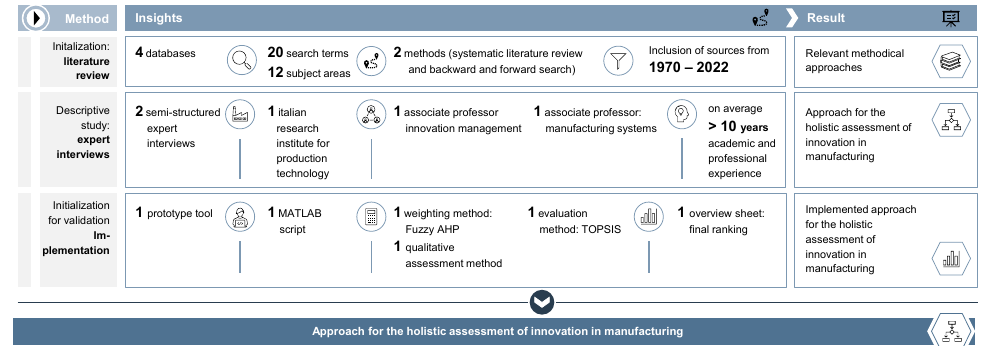
Figure 7. Overview of the methodological derivation of the approach for the holistic assessment of innovation in manufacturing.